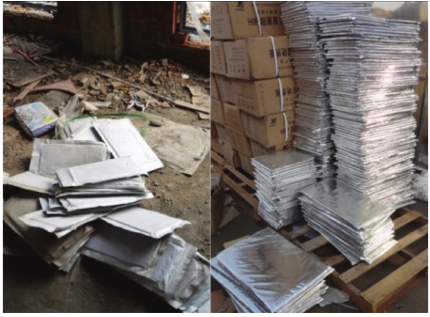
Figure 11: VIP at construction